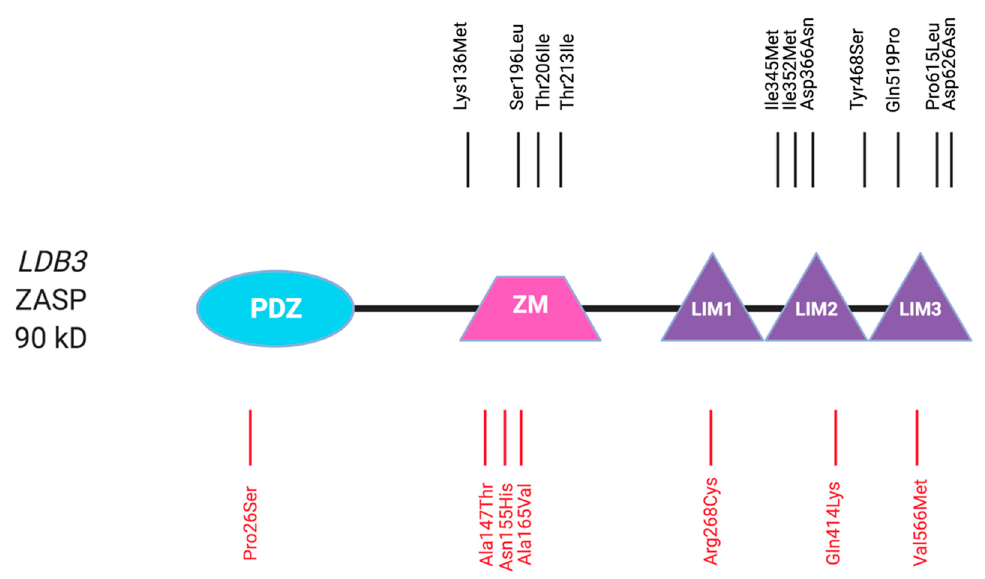
Figure 6. Schematic representation of ZASP shown as a monomer with variants in the LDB3 gene that have been previously reported in individuals with myopathy (red) or cardiomyopathy (black). Solid lines represent missense variants. LIM—Lin-11 Isl-1 Mec-3 (LIM) domain, PDZ—PDZ domain, ZM—ZASP-like motif. Created with BioRender.com (accessed on 7 March